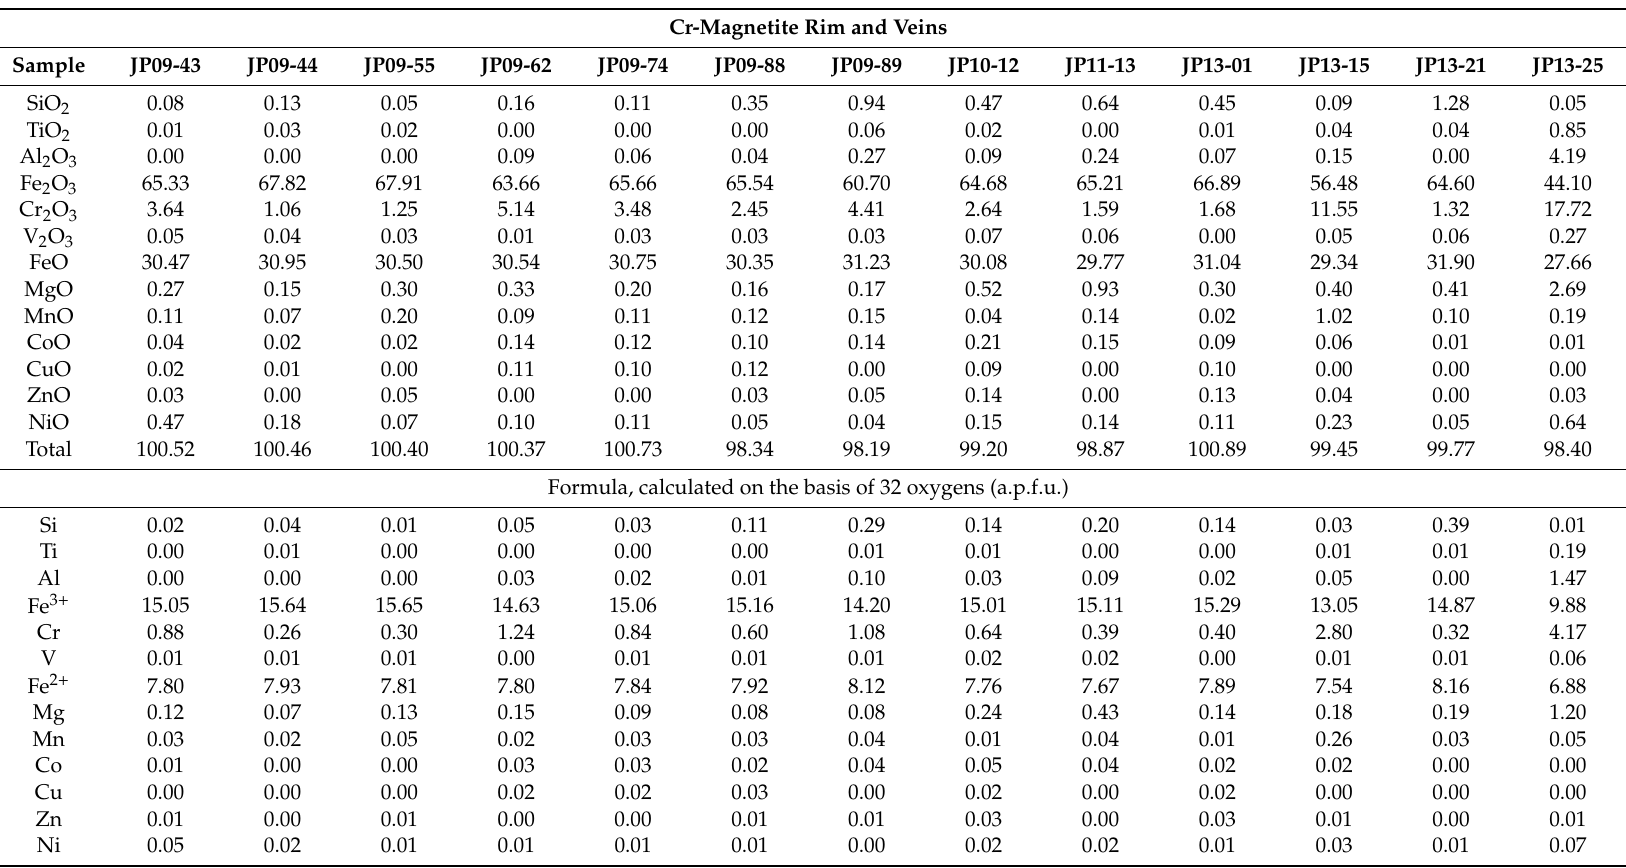
Table 4. The chemical composition of Cr magnetite, ferrian chromite and metamorphic altered chromian spinels (in wt %) with